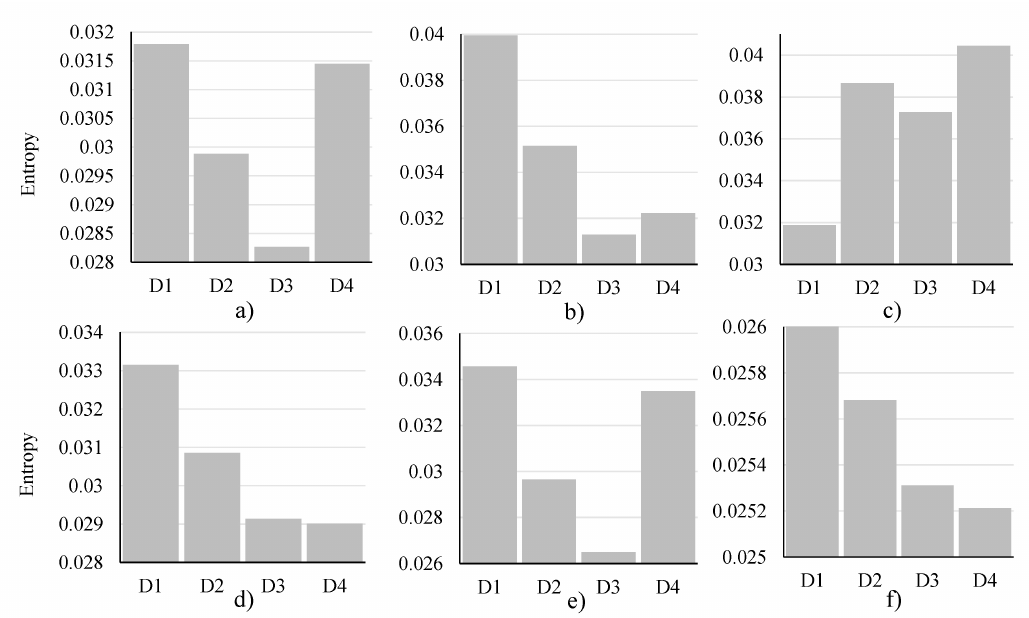
Fig. 5. Average approximate entropy values for each time-series of golf putting kinematics at different distances from the hole. (a) Angular trajectory in x -axis. (b) Angular trajectory in y -axis. (c) Angular trajectory in z -axis. (d) Linear trajectory in x -axis. (e) Linear trajectory in y -axis. (f) Linear trajectory in z